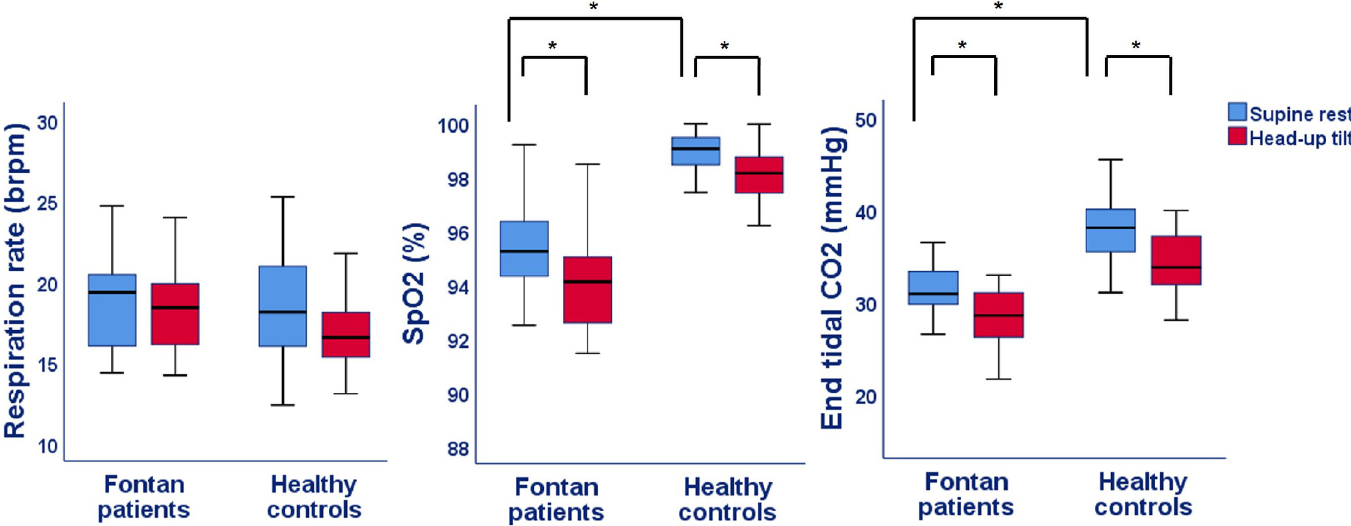
Fig 5. Respiration parameters during supine rest and head-up tilt in Fontan patients and healthy controls. brpm = breaths per minute; SpO2 = saturation; P-value: � < 0.05 for difference in supine rest between Fontan patients and controls as well as difference between supine rest and head-up tilt within Fontan patients or healthy controls.